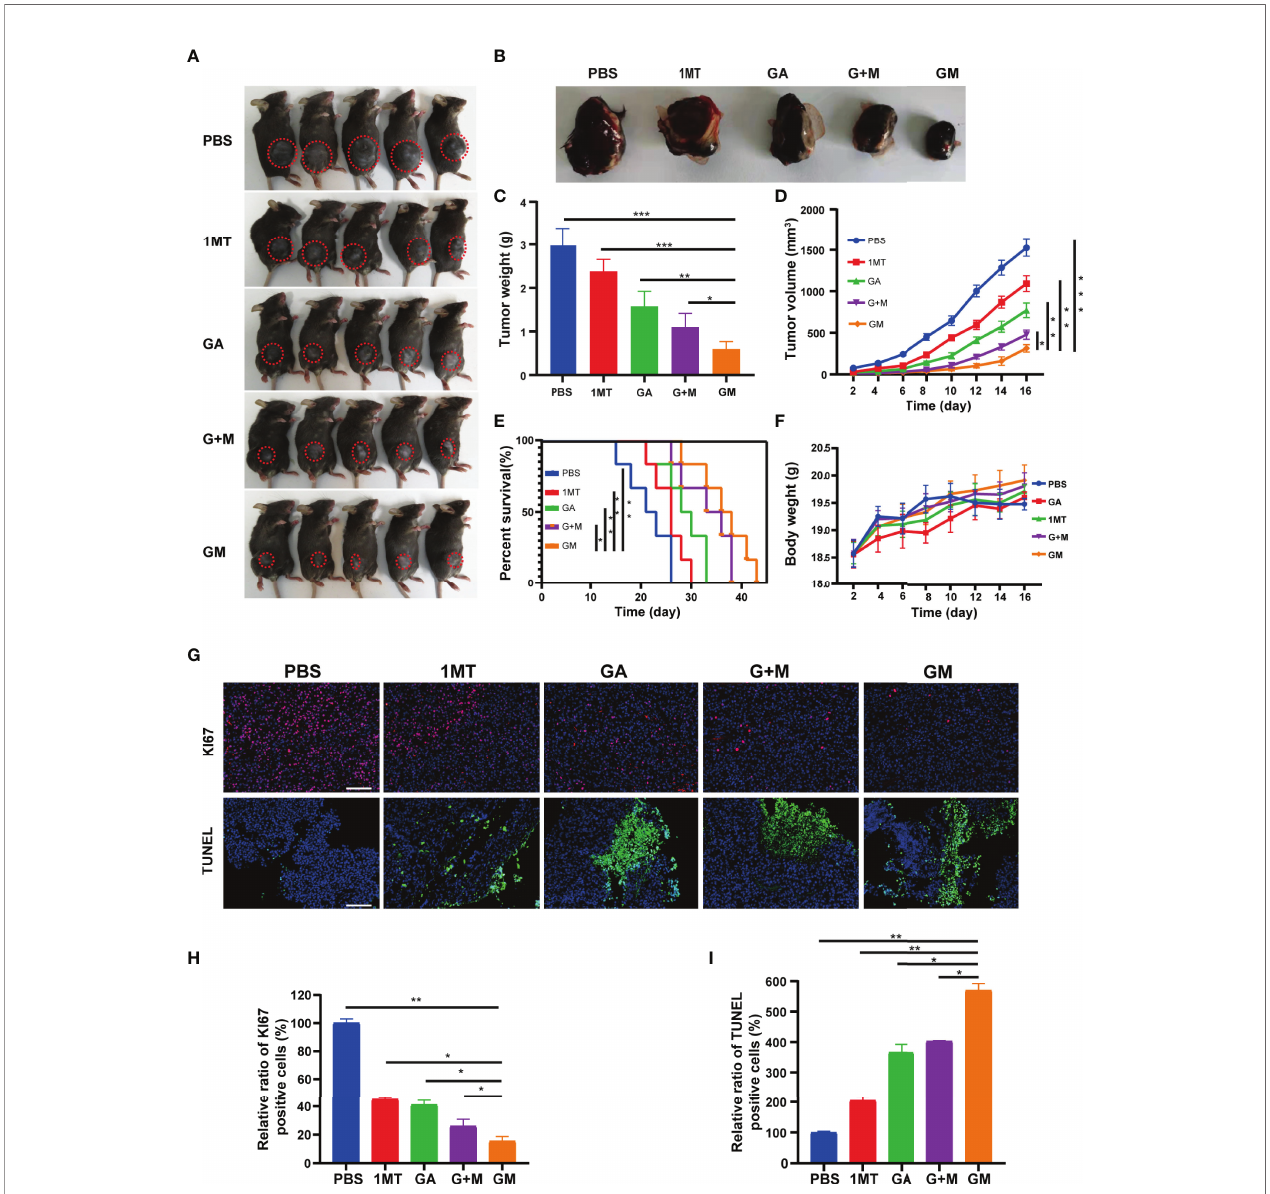
FIGURE 4 | Antitumor effect evaluation in the B16F10 cell tumor model. (A) Representative digital images of mice under different treatments (tumor: red circle). (B) Digital images of tumor tissues removed from mice after different treatments. (C) Tumor weight and (D) tumor growth curve of the tumor-bearing mice from different treatments. (E) Survival curve and (F) bodyweight of the tumor-bearing mice from different treatments. (G) Representative immuno fl uorescence images of Ki67 and TUNEL staining of tumor tissues after the corresponding treatments (scale bar: 200 µm). (H, I) Quantitative analysis of KI67 and TUNEL staining of tumor tissues from different groups. Data are presented as means ± SD, *p < 0.05, **p < 0.01, ***p <